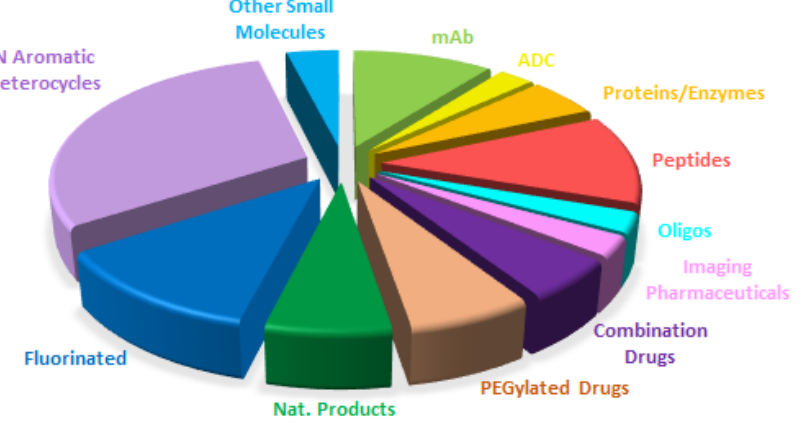
2022, copyright Figure 15. Similar to Figure 14 for the year 2021, taken with permission from reference [1]. Copy- right 2022, copyright MDPI